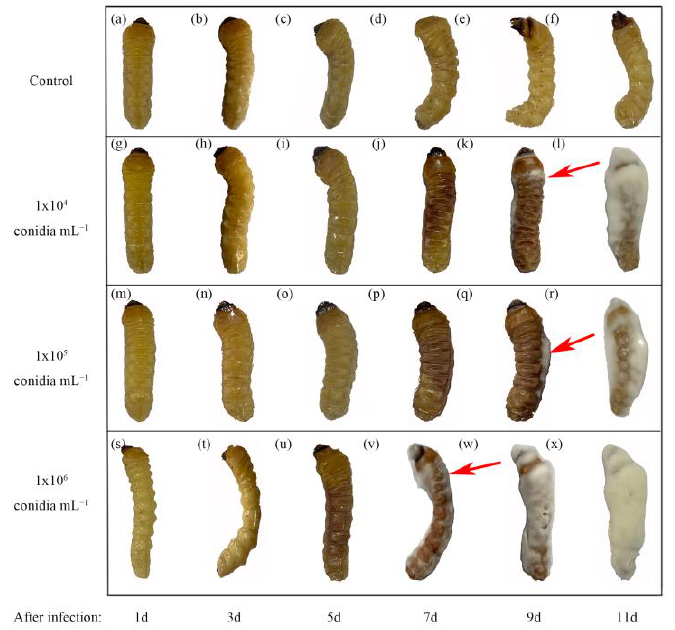
Figure 8. The infection of M. alternatus larvae under different concentrations of B. bassiana spore suspensions (the red arrow indicates the growth of B. bassiana hyphae on the surface of M. alternatus larvae) (a-f: growth of hyphae on the body surface of M. alternatus larvae at 10 4 conidia mL -1 B. bassiana suspension; g-l: growth of hyphae on the body surface of M. alternatus larvae at 10 5 conidia mL -1 B. bassiana suspension; m-r: growth of hyphae on the body surface of M. alternatus larvae at 10 6 conidia mL -1 B. bassiana suspension).